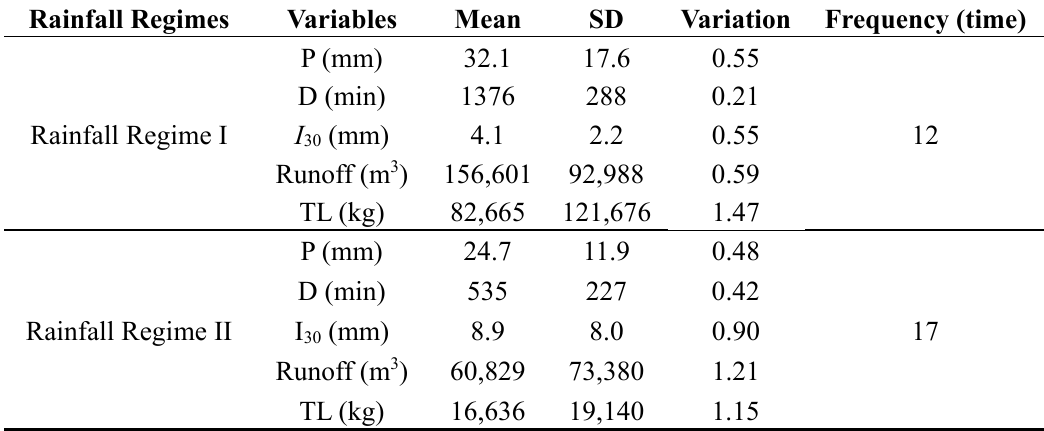
Table 4. Statistical features of the different rainfall